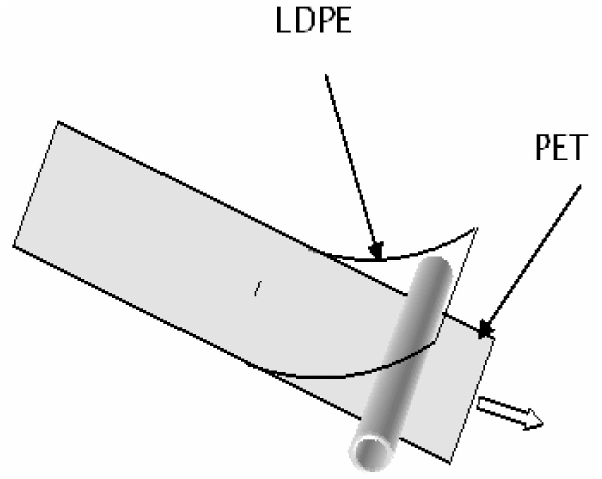
Figure 4. Extrusion of test size LDPE layer from PET laminated with LDPE layers [35].